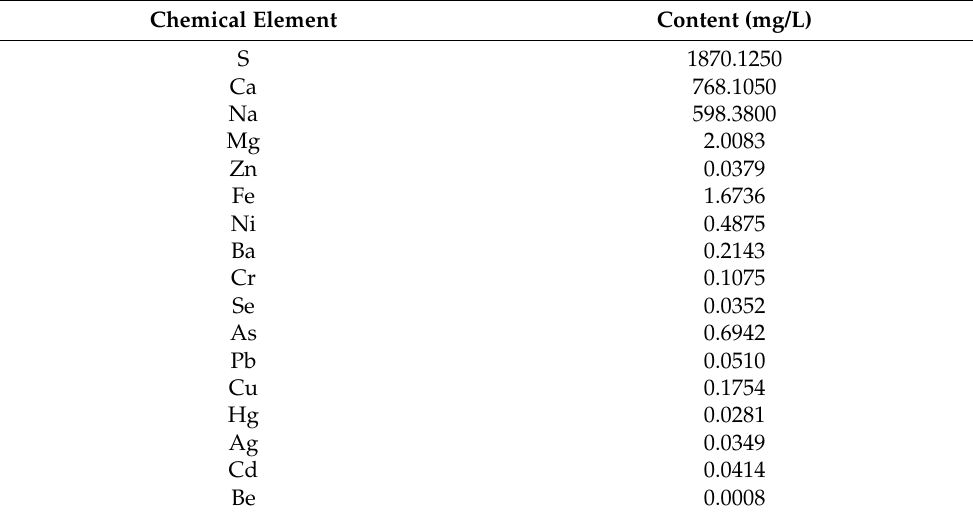
Table 3. Elemental composition of the solution (pH = 7.00) after 270 days of